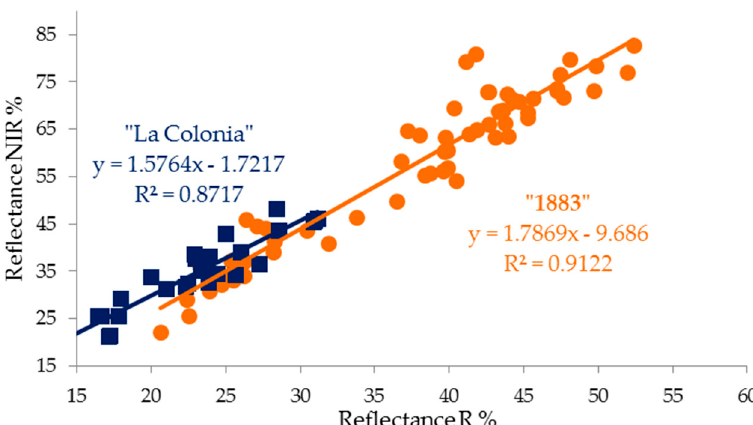
Figure 3. Soil lines for the two sites used in this study: (orange) soil line for Site 1 and (blue) soil line for Site 2. The linear regression function gradient obtained from plotting R against NIR reflectance of sunlit soil is used to calculate the perpendicular vegetation index (PVI), the Modified soil-adjusted vegetation index (MSAVI), and the Soil-adjusted vegetation index 2 (SAVI 2 ). Table 1. List of the vegetation indices used in this study, including acronyms, means of calculation, and salient features.